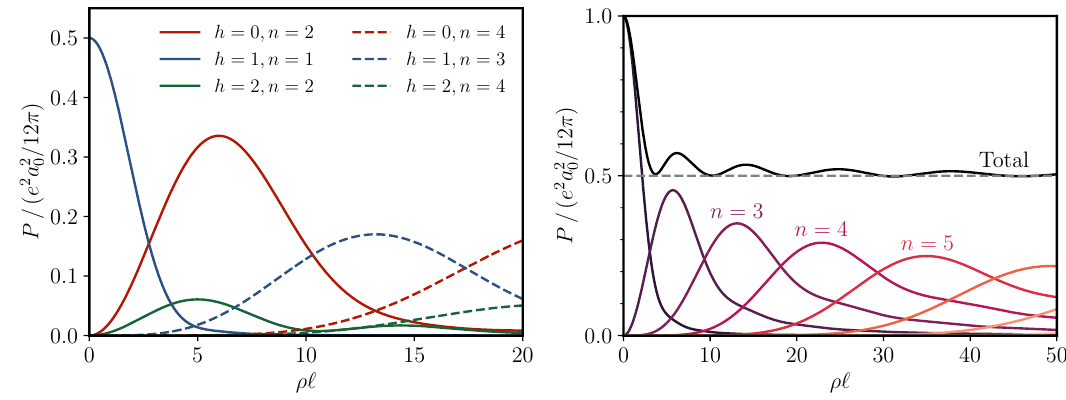
Figure 6 . Radiation from a particle with a vector-like current in nonrelativistic sinusoidal motion of amplitude ‘ , normalized to the power at ρ = 0 . We evaluate (6.73) to find the power emitted in each harmonic and helicity (left), and (6.75) to find the power summed over helicities (right).